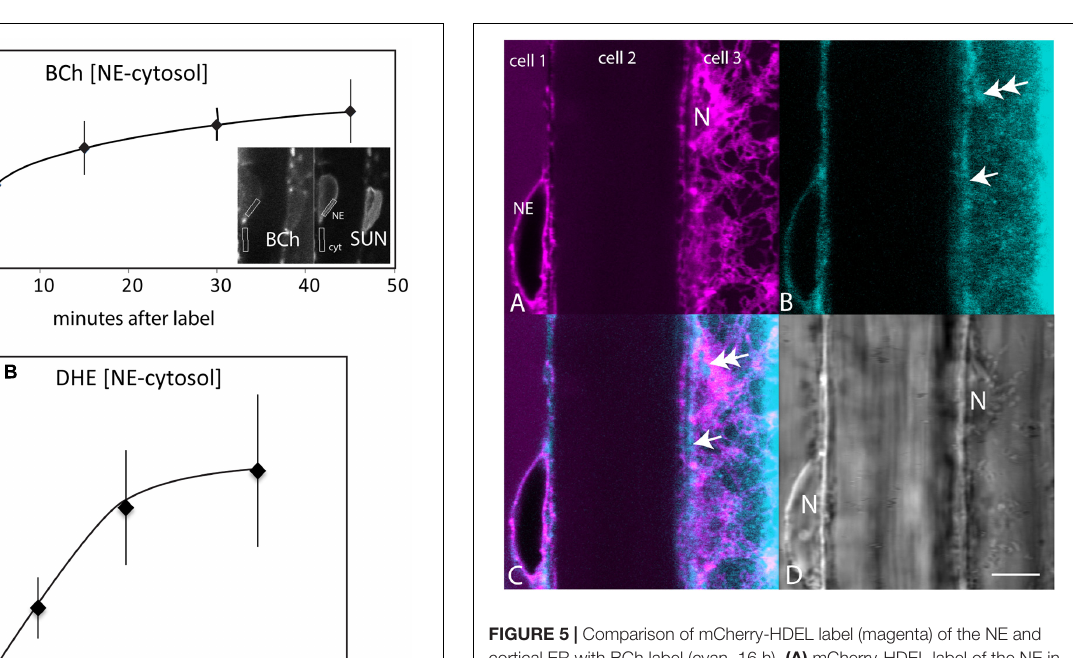
FIGURE 5 | Comparison of mCherry-HDEL label (magenta) of the NE and cortical ER with BCh label (cyan, 16 h). (A) mCherry-HDEL label of the NE in cell 1 and the cortical ER and glancing optical section of the nucleus (N) in cell 3. (B) BCh label of the NE in cell 1 and diffuse label of the cortical region of the cytoplasm in cell 3. Double arrow points to the region on the glancing section of nucleus. Single arrow points to PM. (C) Merged image of (A and B) . (D) Bright-field image N, nuclei. The nucleus in cell 3 is in the glancing optical section. Scale bar = 10 µ